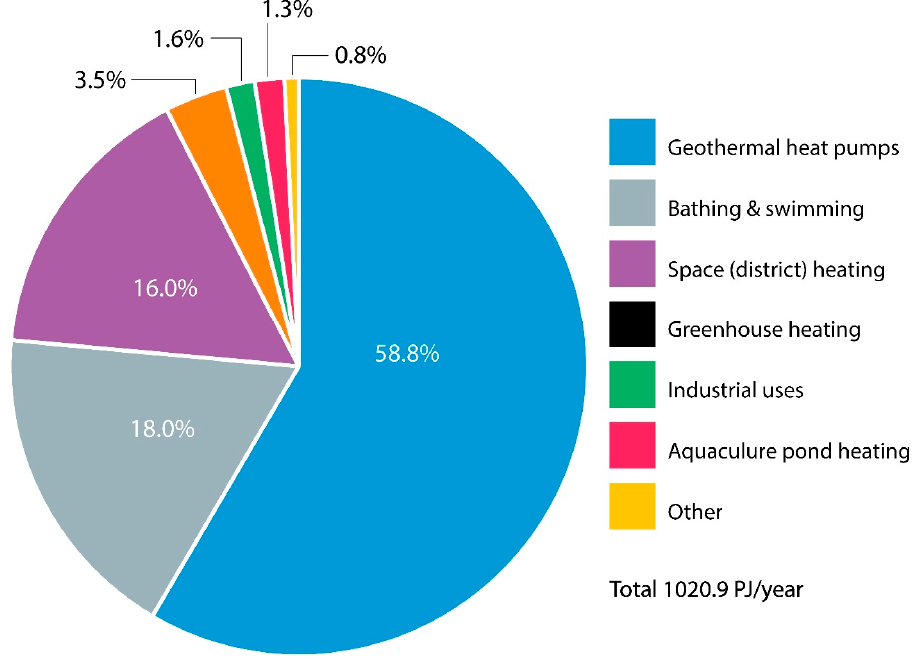
Figure 2. Various global geothermal direct uses in 2020. Data from [3] are plotted.